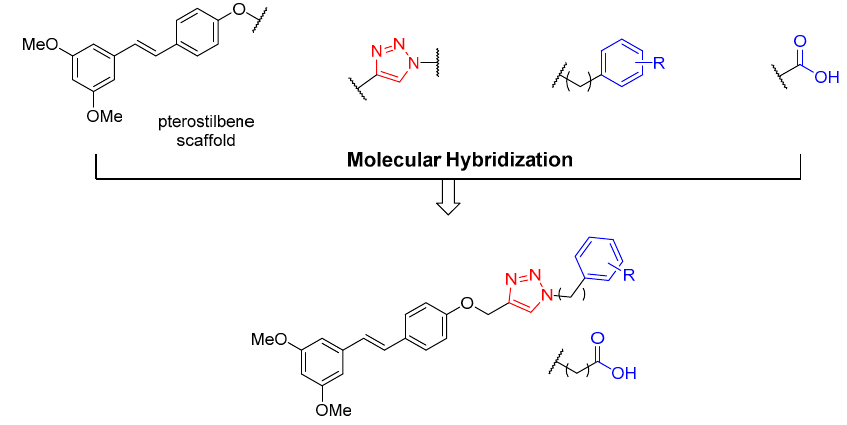
Figure 2. Design strategy of novel hybrid pterostilbene derivatives.